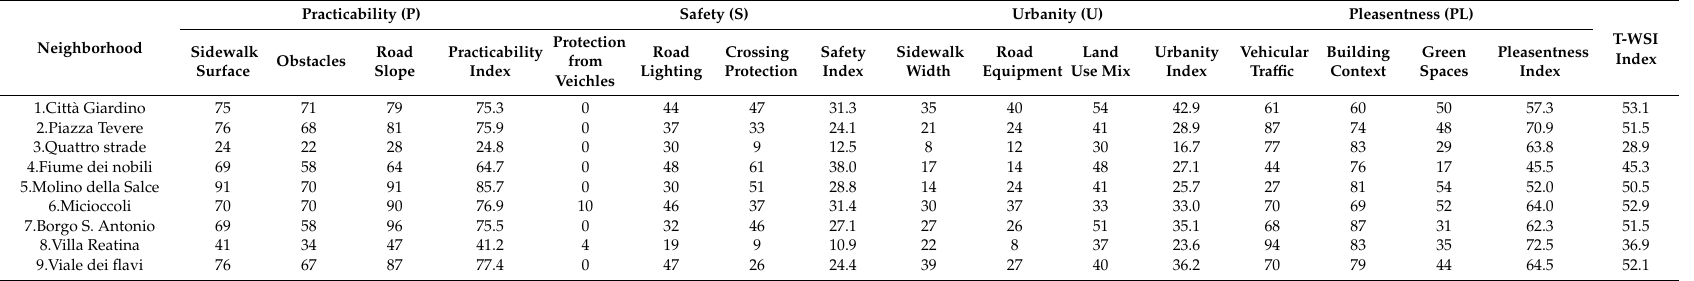
Table 3. Average results of indicators, indexes and T-WSI obtained in each neighborhood in the investigation performed in 2018.